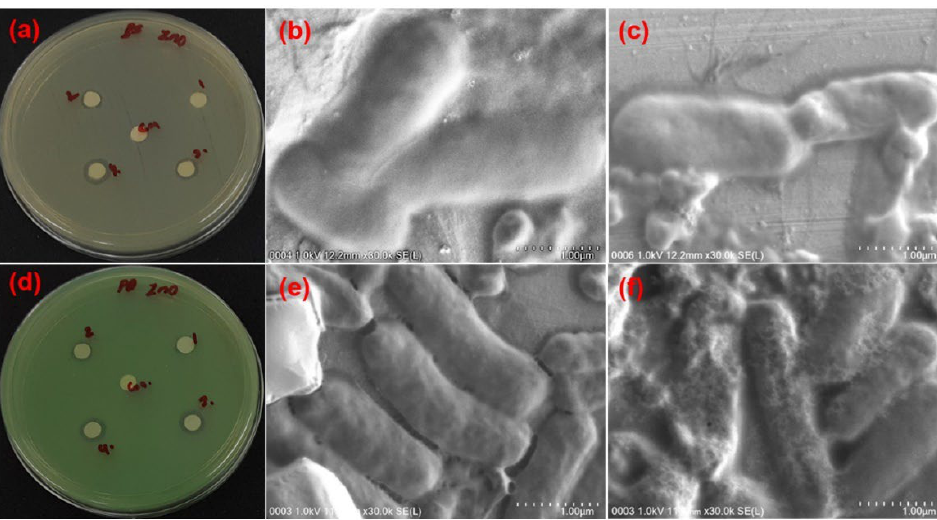
Figure 9. Antibacterial disc diffusion assay of ZnO NS against B. subtilis and P. aeruginosa ( a , d ). Discs 1, 2, 3, 4 and control were loaded with 20 µL of ZnO NS (100, 200, 300, 400 µg/mL) and DW. FESEM image of bacterial control ( b , e ) and after ZnO NS treatment ( c , f